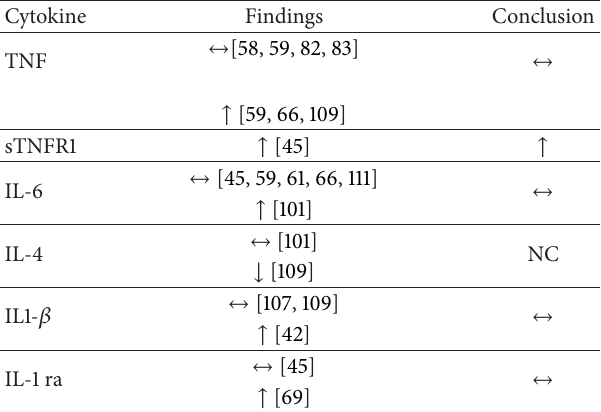
Table 3: Cytokine peripheral levels in bipolar disorder patients in depressive state compared with